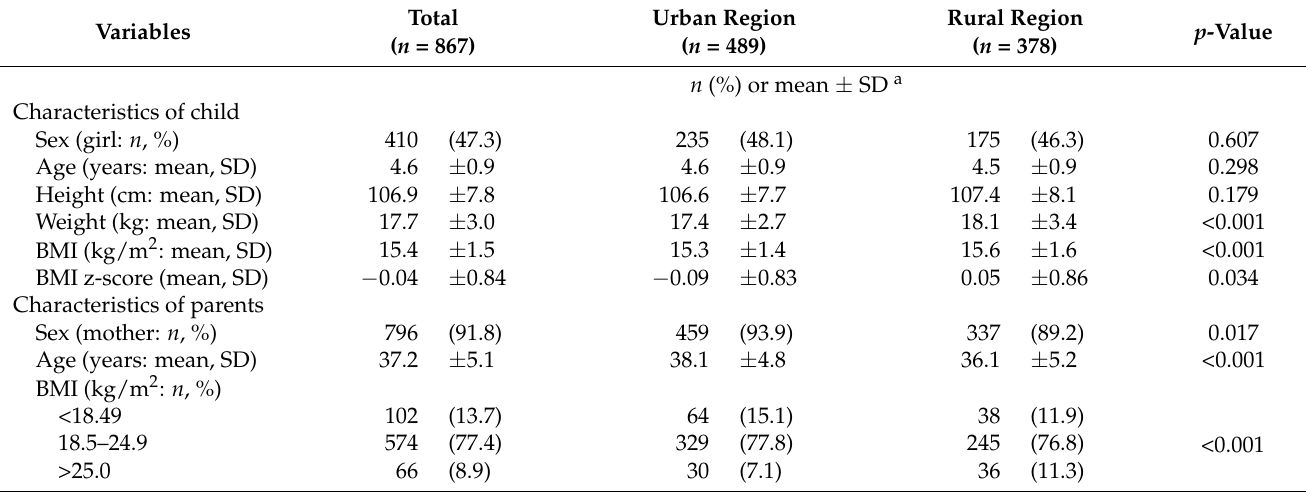
Table 1. Sociodemographic characteristics and urban/rural differences among parents and their